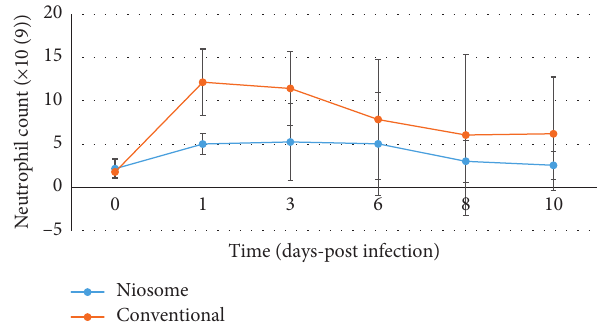
Figure 7: Graph showing neutrophil counts in Sprague Dawley rats after infection with Pseudomonas aeruginosa and treatment with niosome and conventional levofloxacin ( p < 0 . 049).